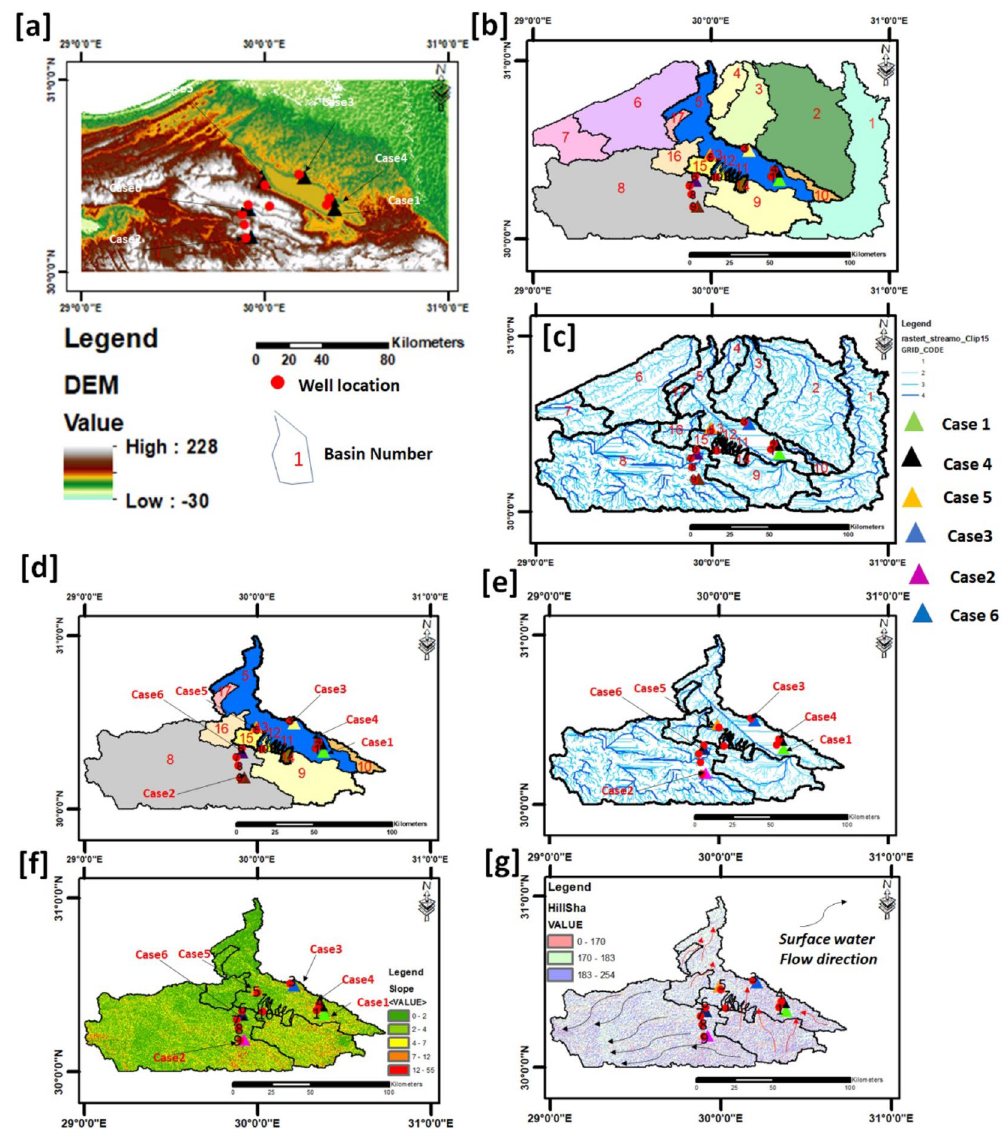
Figure 12. ( a ) Digital elevation map [DEM], ( b ) main basin and sub basins with number of each subbasins, ( c ) stream orders of the selected basins and subbasins, ( d ) area of interest (aoi) and its subbasins and attributes with the main stream orders, ( e ) slop map [0°–55°]. ( f ) Hill shade map with the main stream order of wadi El Natrun Basin_5 and basins B_8 to B_17, the pale blue arrows pointed out the directions of surface water to wadi El Natrun and its vicinities all over the studied